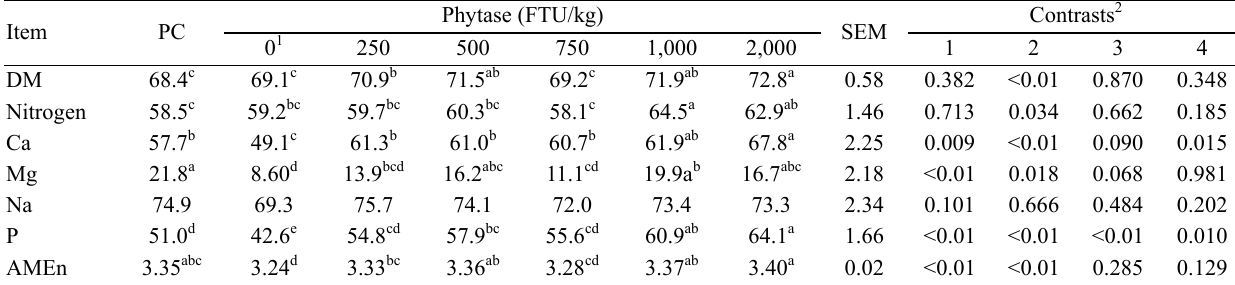
Table 5. Influence of phytase dose on apparent retention (%) and AMEn (kcal/kg DM) in 21-d old broilers fed corn/soybean meal diets Phytase Item PC